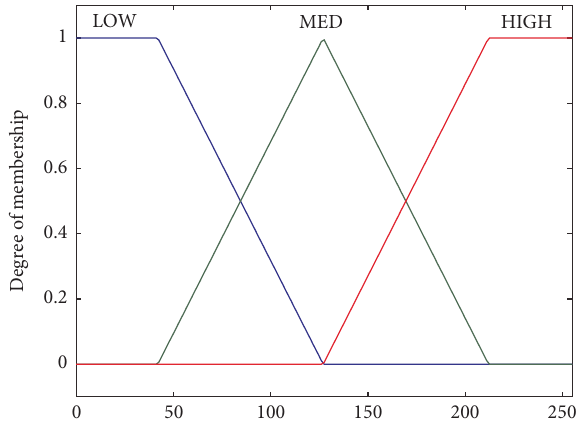
Figure 1: The membership functions of input 𝐺𝑋 , 𝐺𝑌 , HP, and LP.